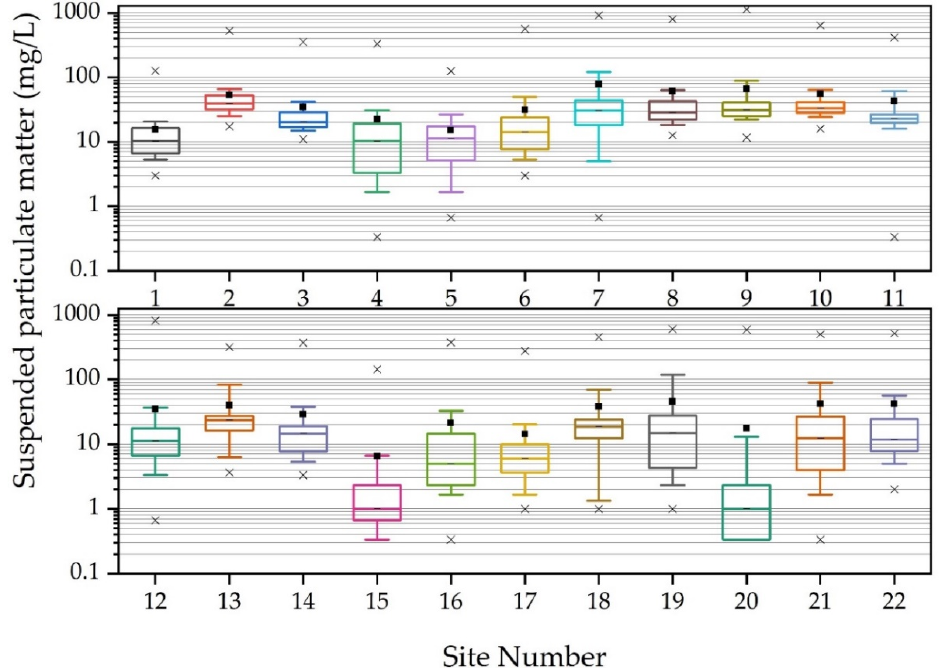
Figure 3. Box and whisker plots of suspended particulate matter (mg L − 1 ; log 10 scale) at each sampling location (n = 22) during the study period (2 January 2018–1 January 2019) in West Run Watershed, Morgantown, West Virginia, USA. Boxes delineate 25th and 75th percentiles; lines denotes medians; squares shows means; whiskers describe 10th and 90th percentiles; x shows maxima and minima when above and below, respectively. Note: different box colors represent data from different sites.